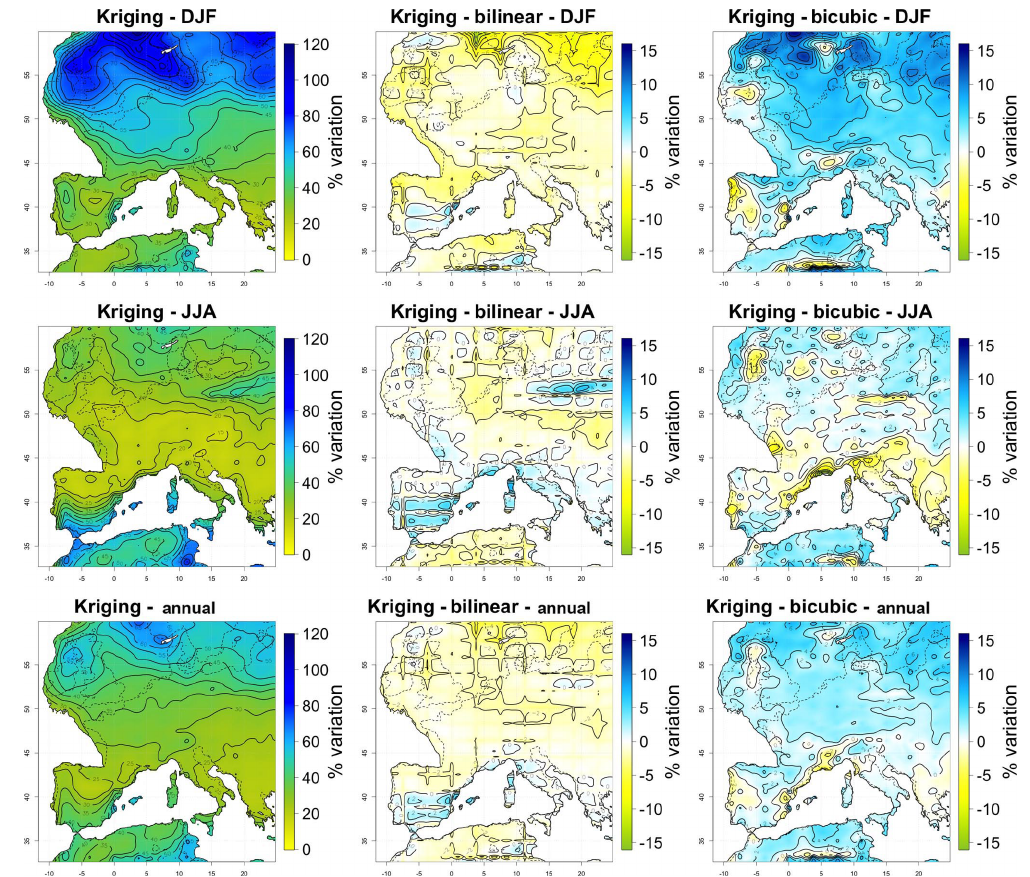
Figure 10. Maps of temporal variations (coefficient of variation of each month across 50 years) of downscaled daily precipitation over western Europe during the LGM averaged over winter (December, January, February), summer (June, July, August) and the whole year, computed over 50 years for the kriging interpolation technique, and difference between the kriging and the other two techniques. Variability was computed for each month independently, but results are combined into seasons to summarise the